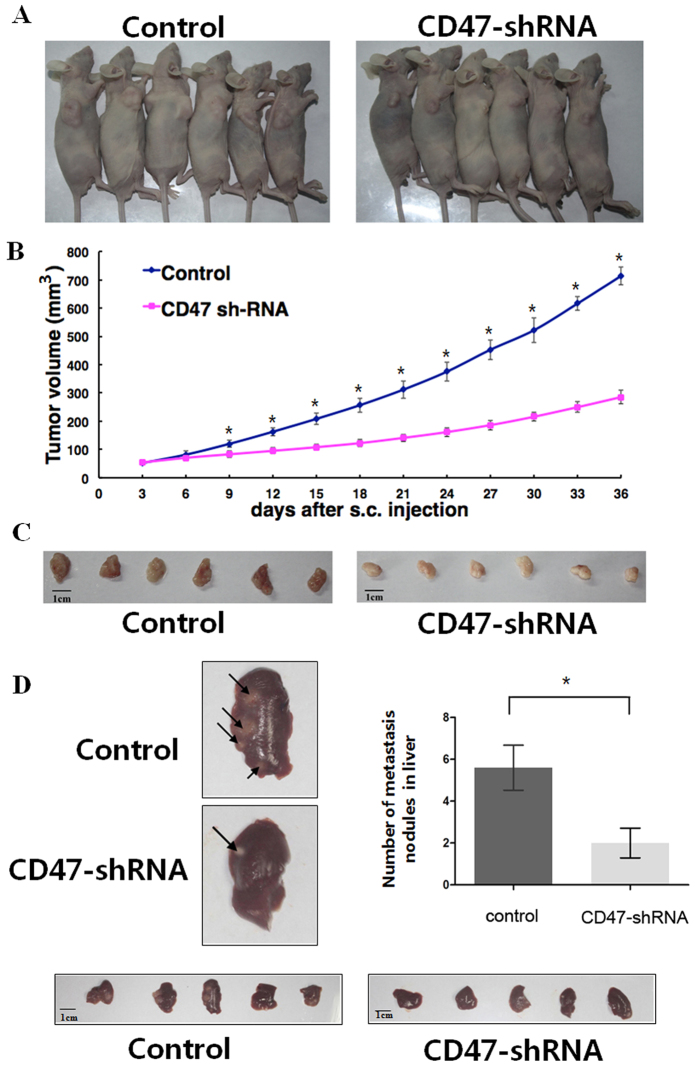
CD47 inhibits the growth and metastasis of NSCLC xenografts in vivo.(A) Photographs of mice bearing subcutaneous tumors from A549 cells stably transfected with control shRNA (left) and CD47-shRNA (right) on day 36 after cell injection. (B) Tumor growth curve over time; *P < 0.05. (C) Photographs of isolated tumors on day 36 after tumor cell injection. (D) Representative pictures of mouse liver are presented. Arrows indicate metastatic nodules on liver surface. The number of metastatic nodules in mice (n = 6/group) significantly decreased in the CD47-shRNA group (*P < 0.05).